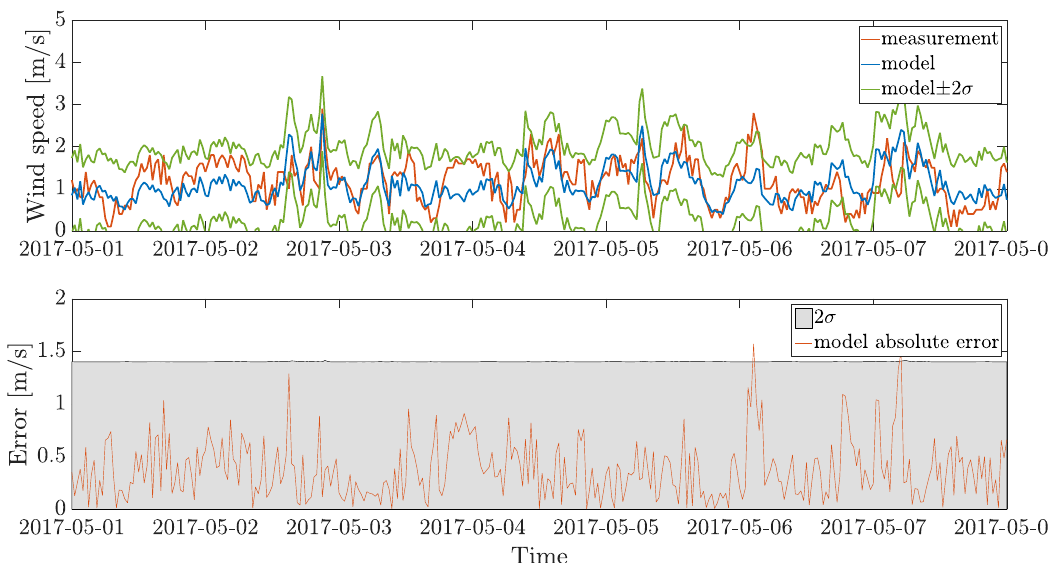
Figure 6. Comparison of measurement and model results for Brežice for the first week of May 2017. The model used is a linear regression with least squares model trained on November 2017 data, referred to as Model 11 in Figure 5. It can be seen that the predicted mean value reasonably follows the measured signal and that the predicted variance is nearly constant and reasonable. The figures of merit for the model are R = 0.6906, R 2 = 0.4760, MSE = 0.2345, and MSLL = − 0.3155 when computed over the whole 11-month test period.